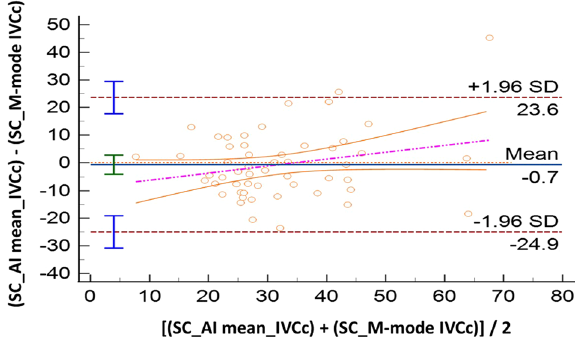
Fig. 1 Bland–Altman plot for the inferior vena cava collapsibility index (IVCc) measured in subcostal (SC) site with standard M-mode or artificial intelligence (AI). SD: standard deviation